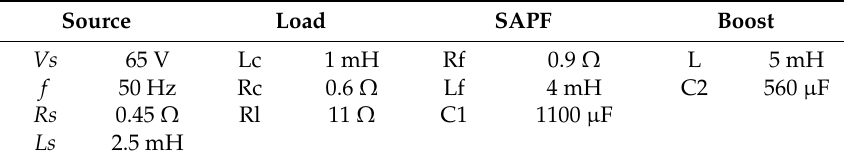
Figure 10. FFT analysis of supply current before connecting the filter. The filtered current waveform when using the conventional DPC strategy is shown in Figure 11a. It was observed that the fifth and the seventh harmonic components appear in the spectrum graph in addition to the fundamental component. However, the obtained current after filtering has a